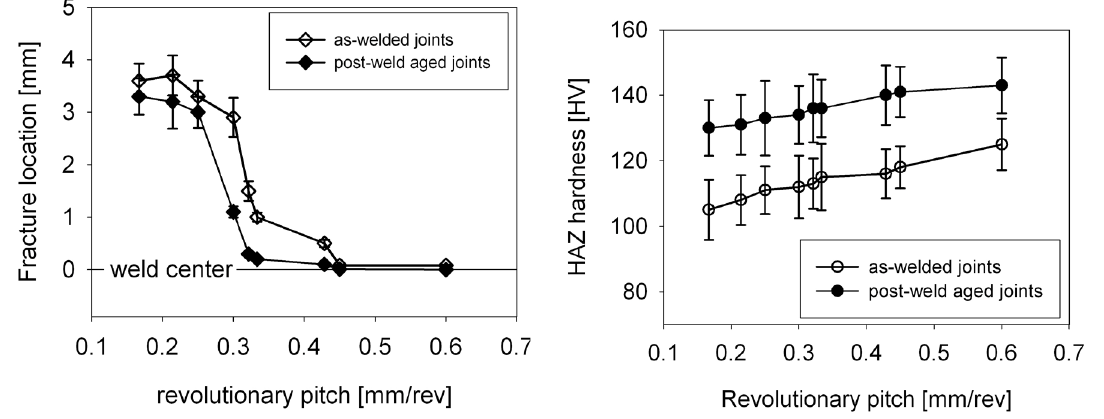
Figure 6. Fracture location of the joints as function of the RP (median over four specimens, the 80% confidence limits are reported).